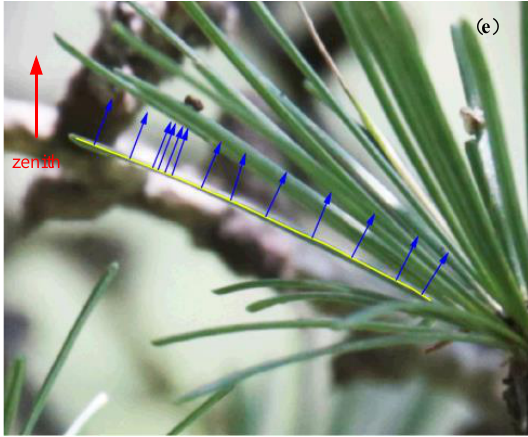
Figure 2. The flow chart of the quasi-automatic method used to measure the needle inclination angle based on the line segment detector (LSD) algorithm and photographs acquired by the leveled digital photography method. The target needle ( a ) is the same as the target in Figure 1. The blue lines and arrows ( e ) denote the normal directions of the line segments detected by LSD.